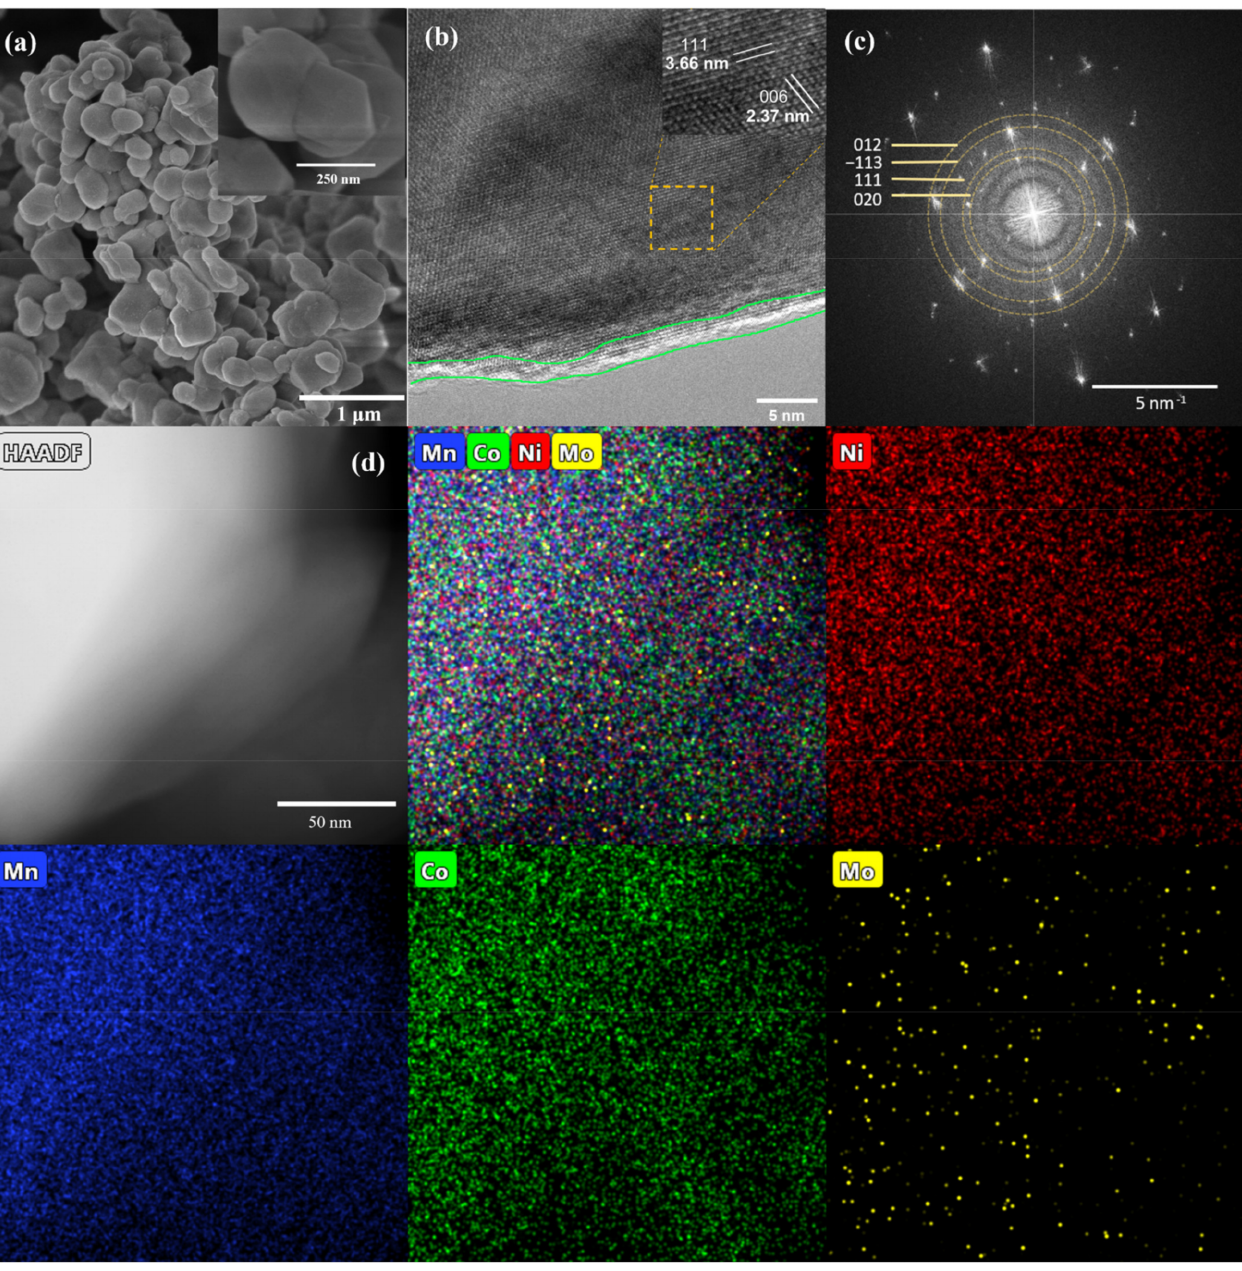
Figure 2. SEM ( a ), HRTEM ( b ), and ED pattern ( c ) of LMR-Mo, and HAADF and EDS mapping ( d ) of Ni (red), Mn (blue), Co (green), and Mo (yellow) for